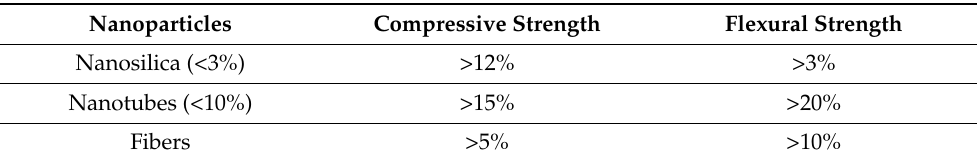
Table 4. Variation of compressive and flexural strengths based on the added percentages